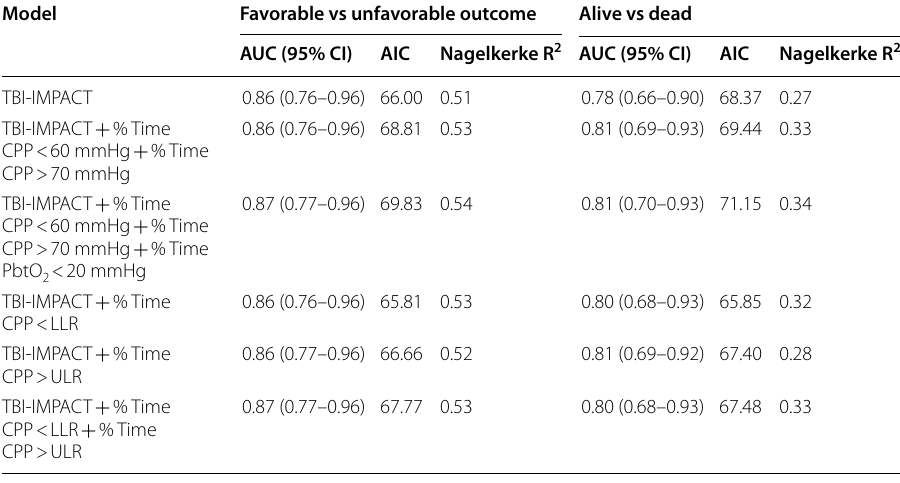
Table 2 Performance of various multivariable logistic regression models to predict 6-month post- injury